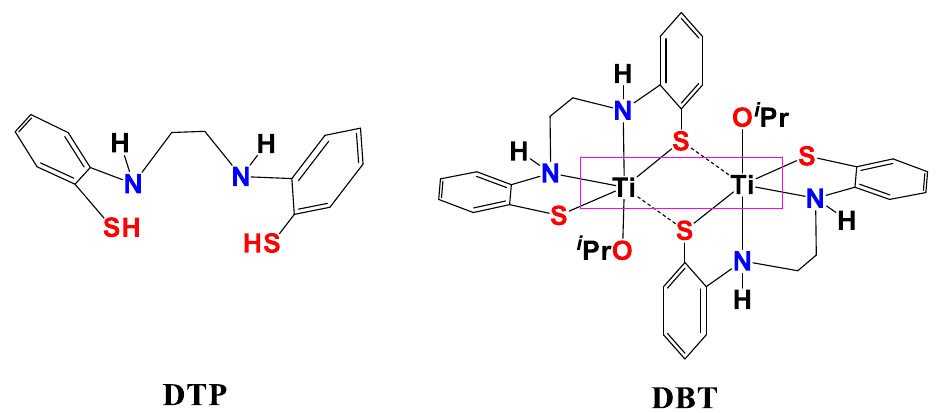
Figure 1. Structure of Dithiophenolato [ DTP ] and the Dithiophenolatotitanium (IV)-complex